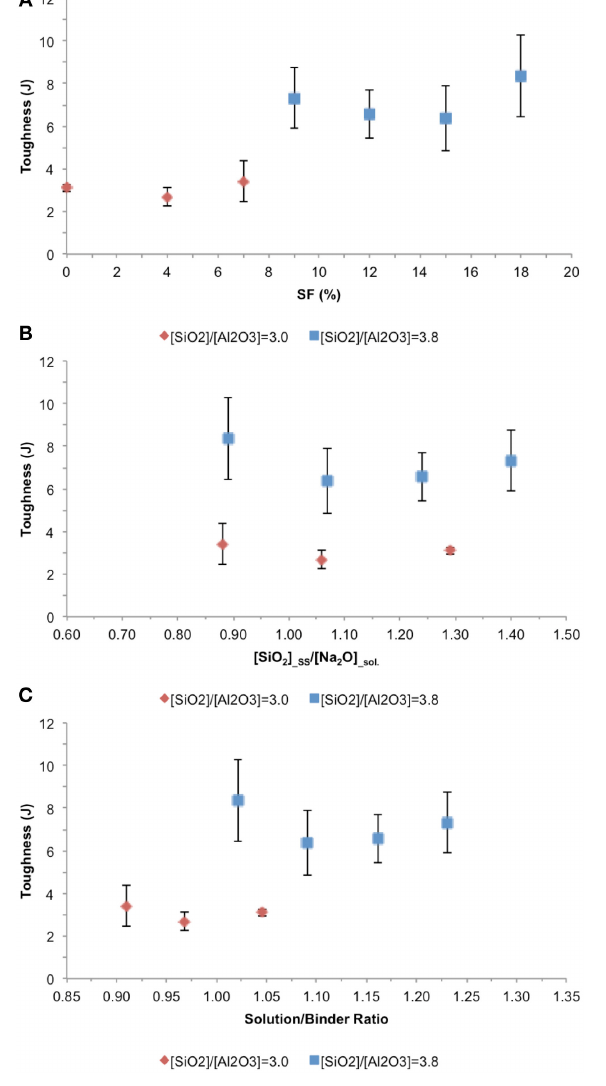
FIGURE 8 | Toughness as a function of (A) amount of SF in the system; (B) [SiO 2 ] _silicate /[Na 2 O] _sol. ratio in the activator; (C) Solution/solids ratio.